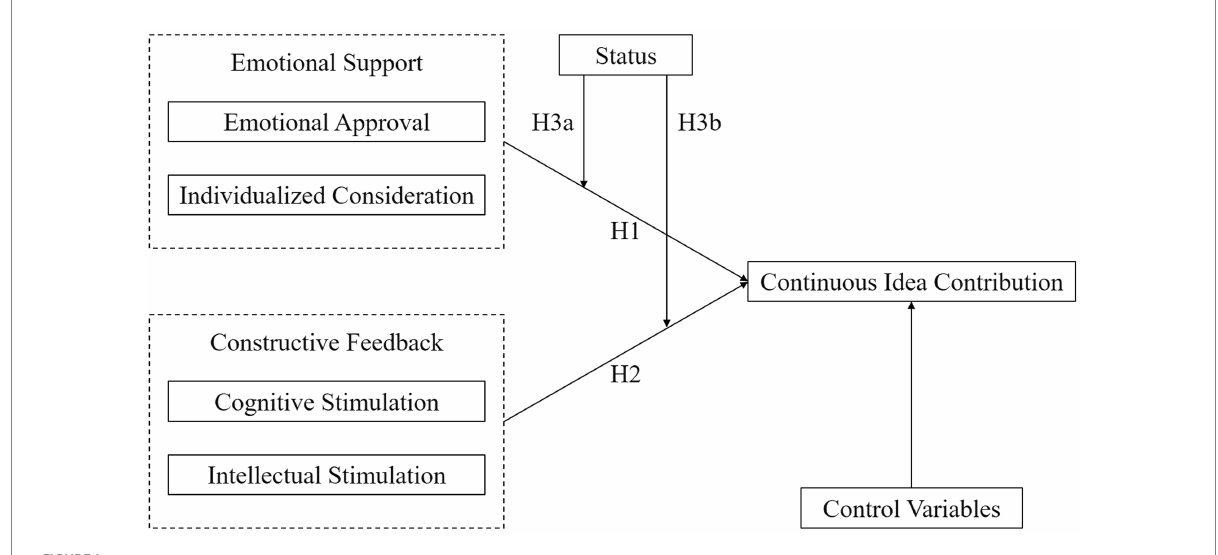
FIGURE 1 The conceptual